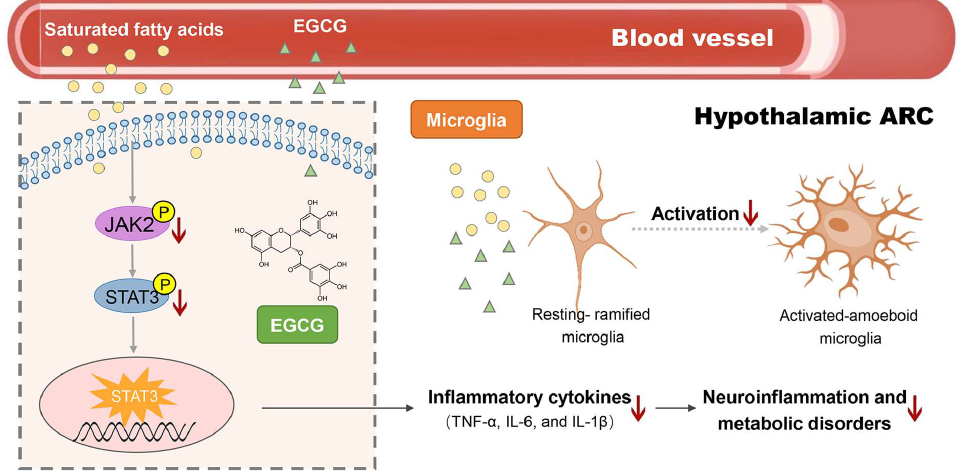
Figure 5. Possible neurological mechanisms of (−)-epigallocatechin gallate (EGCG) on HFD-induce obesity.